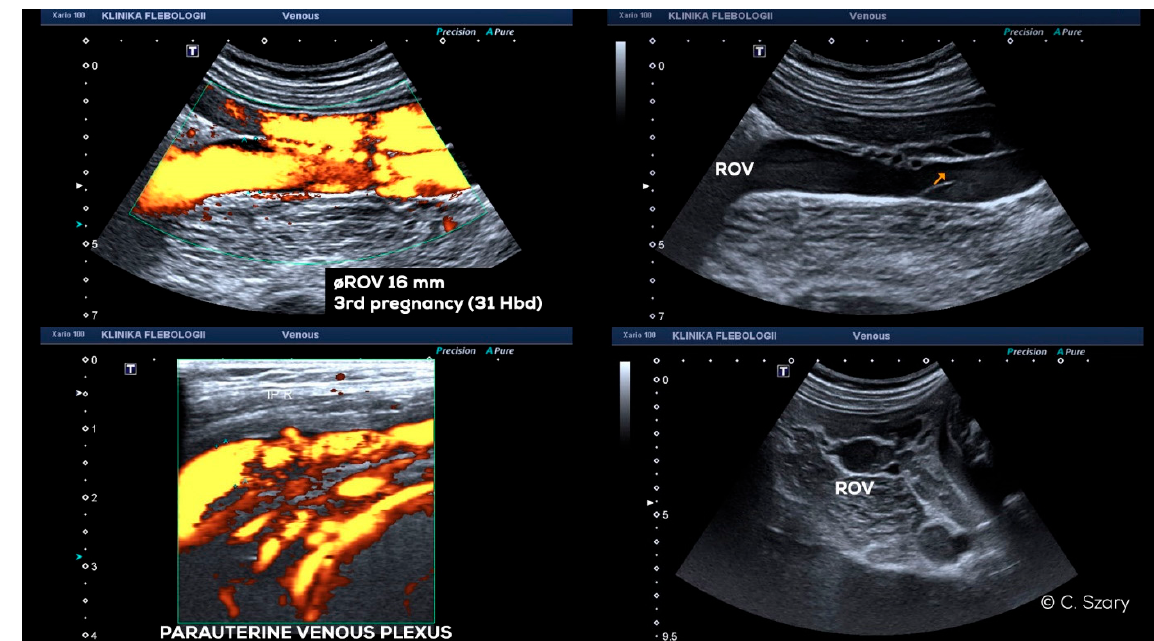
Figure 16. Transabdominal CDU findings of 35-year-old woman in third pregnancy (31 Hbd); distension of the ROV (16 mm) with reversed flow and dilated para-uterine venous vessels and varices of round ligament.